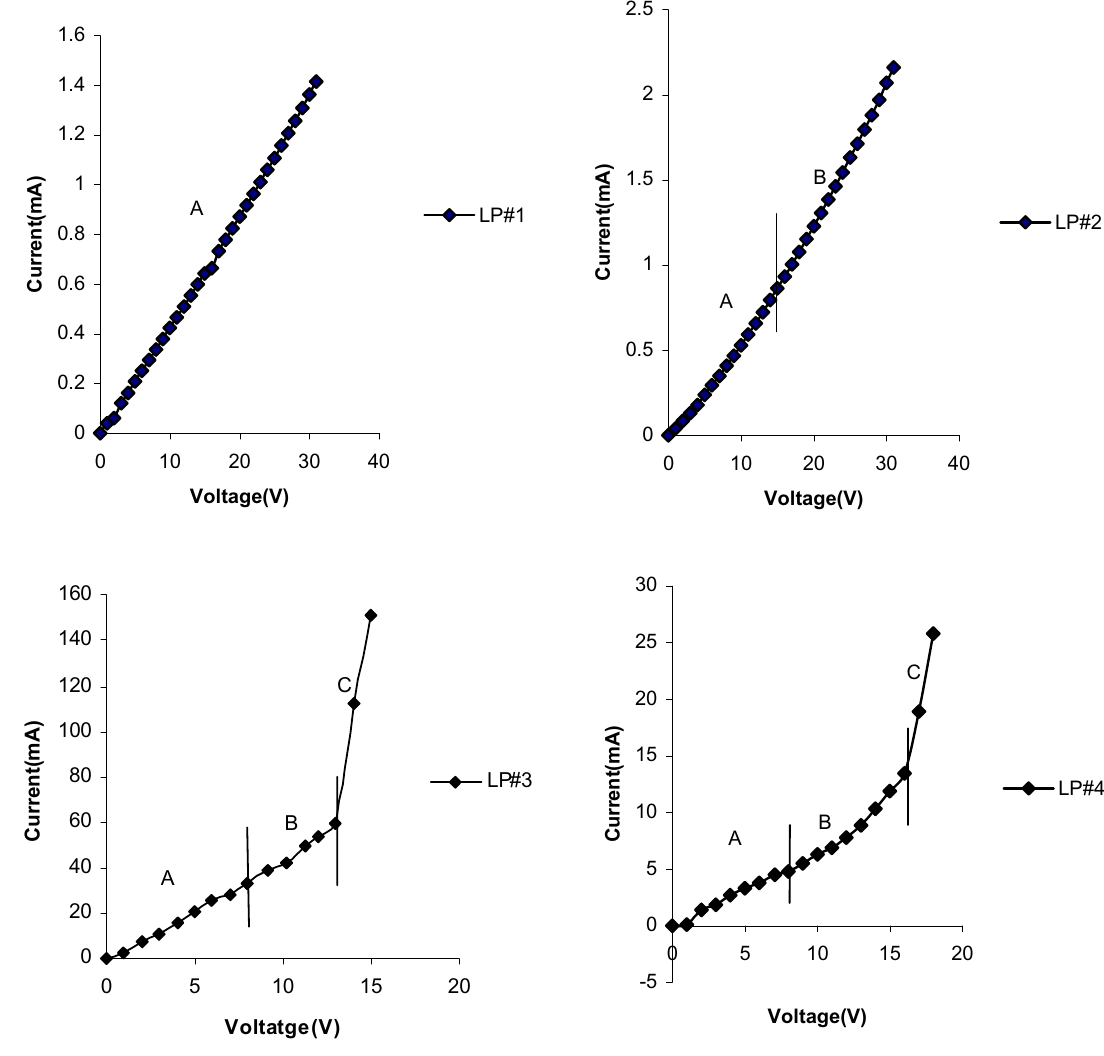
Figure 7. I-V plots for the In